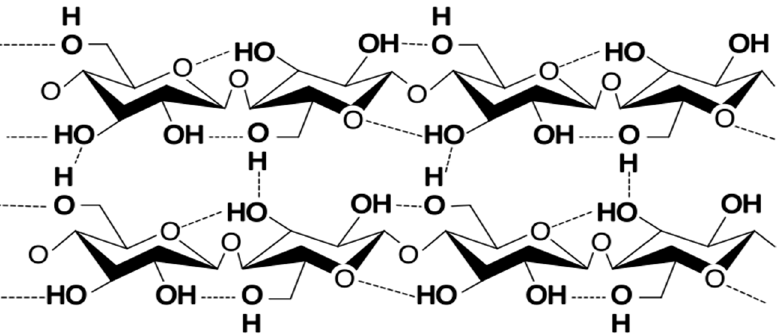
Figure 29. Crystalline structure of cellulose, note the inter and intra hydrogen bonding (dashed lines denote hydrogen bonds).